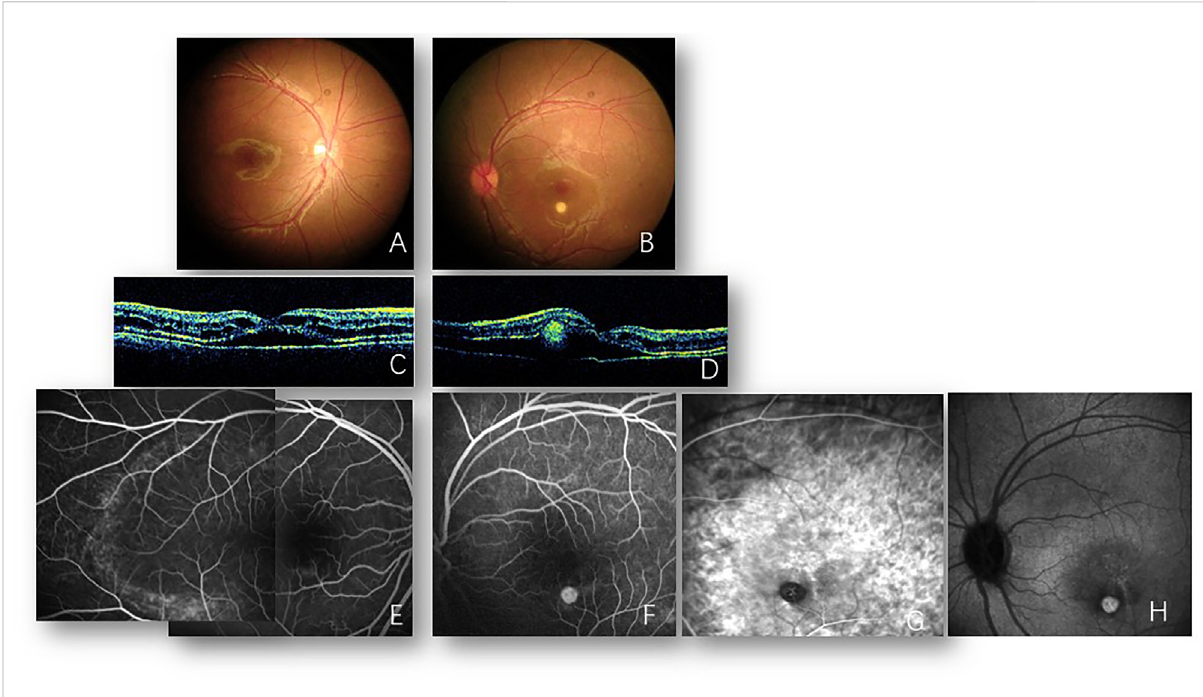
FIGURE 1 Images from 2008. Fundus photos of the right (A) and left (B) eyes reveal bilateral cystoid changes in the macula. A round yellowish subretinal lesion inferior to the macula of the left eye is also shown (B) . Optical coherence tomography of the right (C) and left (D) eyes reveals the splitting of retinal layers and foveal neurosensory retinal detachment with cystic changes. Subretinal hyperre fl ectivity lesion is also noted in the left eye (B) . Fluorescein angiography of the right eye (E) reveals multiple hyper fl uorescent dots on the temporal macula. A round hyper fl uorescent lesion